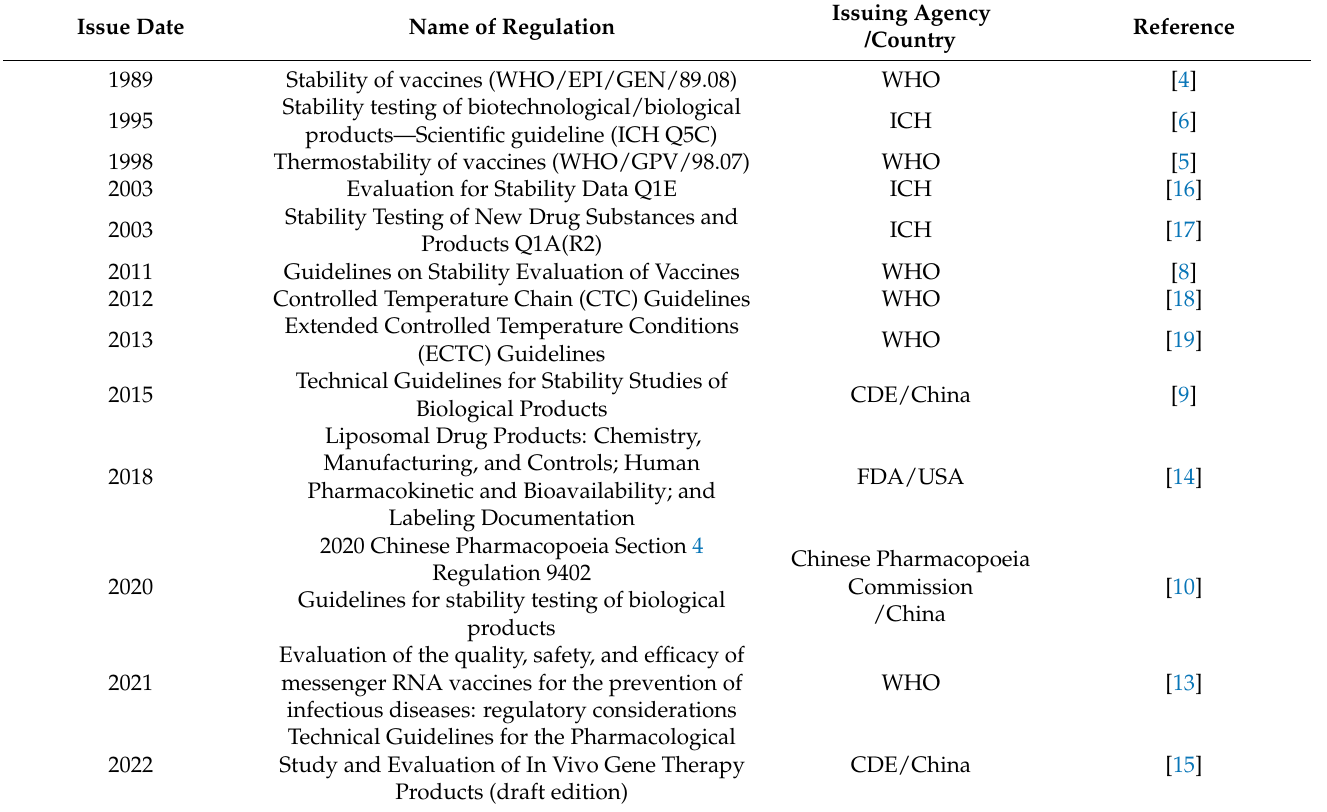
Table 1. Regulations and guidelines related to vaccine